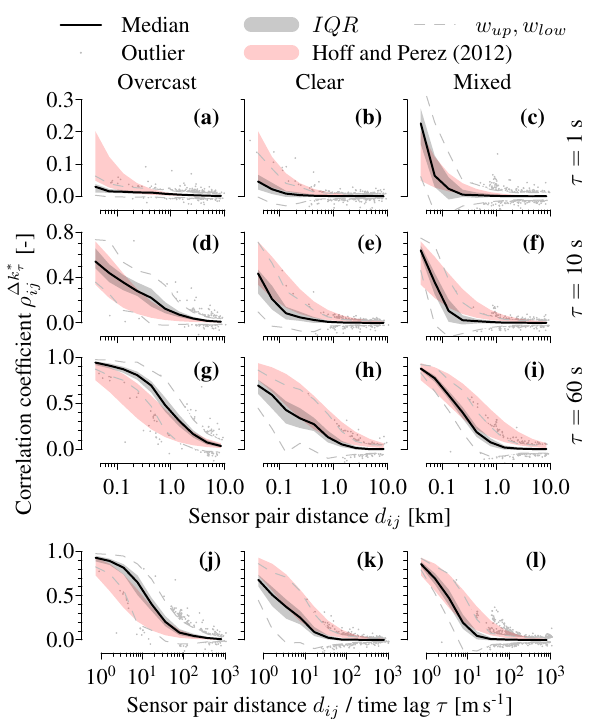
(cid:49)k ∗ τ ij of